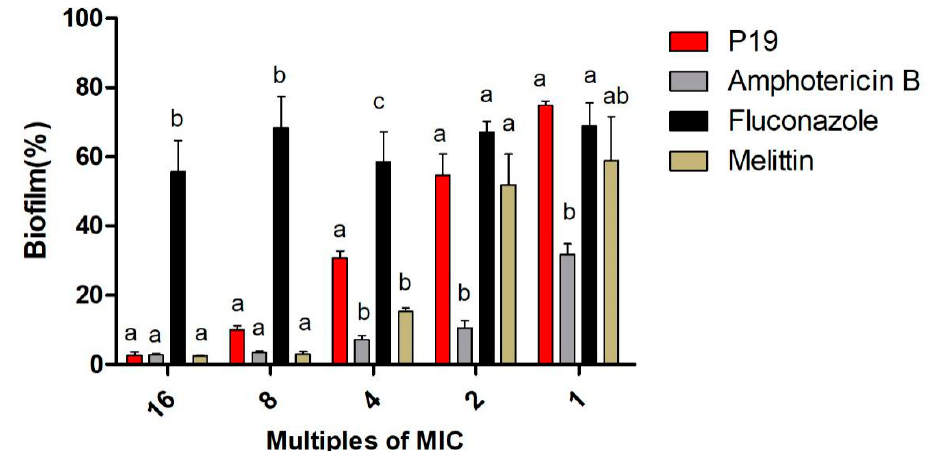
Figure 5. C. albicans cgmcc 2.2086 biofilm eradication potential of potential peptide, broad-spectrum peptide, and antibiotics. Data were plotted as percent of biofilm eradication by setting the untreated biofilm as 100% of biofilm. Data represented here were from three replicates. Different letters represented statistically significant ( P < 0.05).